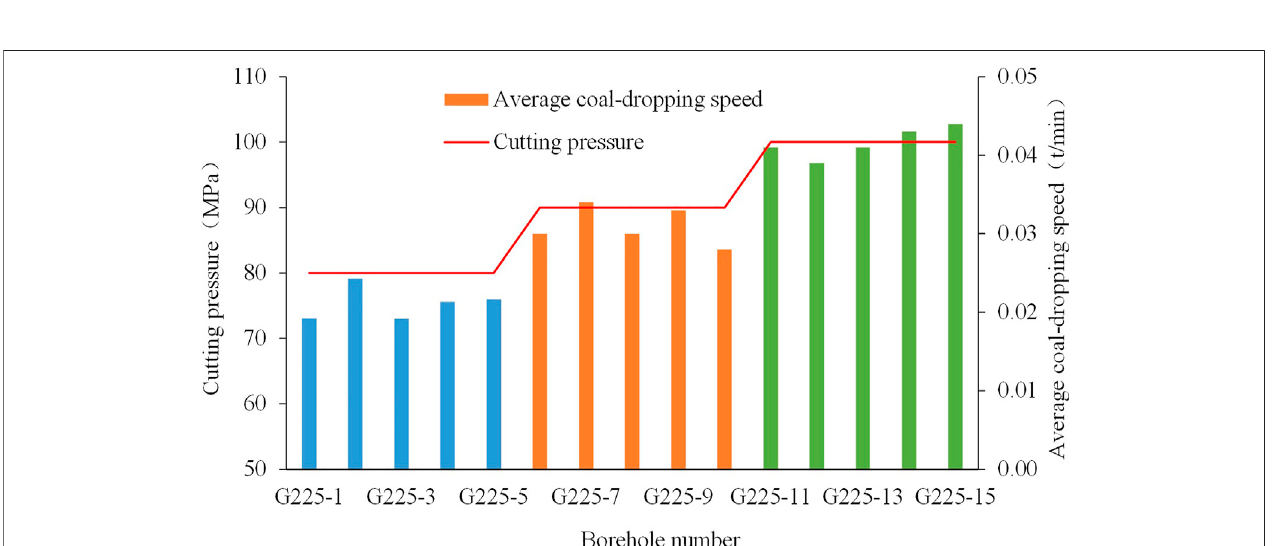
Frontiers in Earth Science |